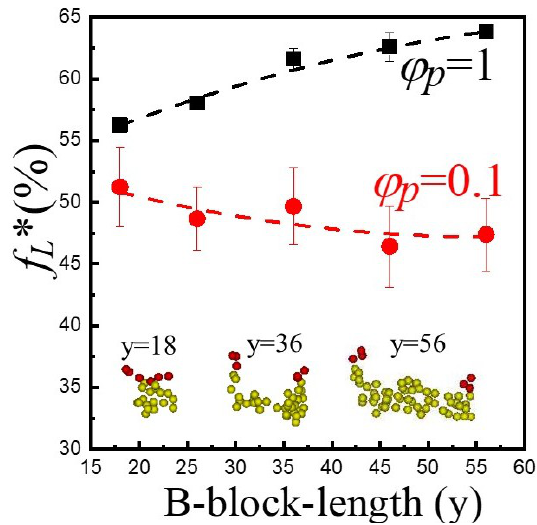
Figure 8. The variation of f ∗ as a function of hydrophobic B-block length (y). The hybrid membrane is formed by lipids and A 3 B y A 3 with ϕ p = 0.1. Red and yellow beads represent hydrophilic and hydrophobic beads of the copolymer, respectively.